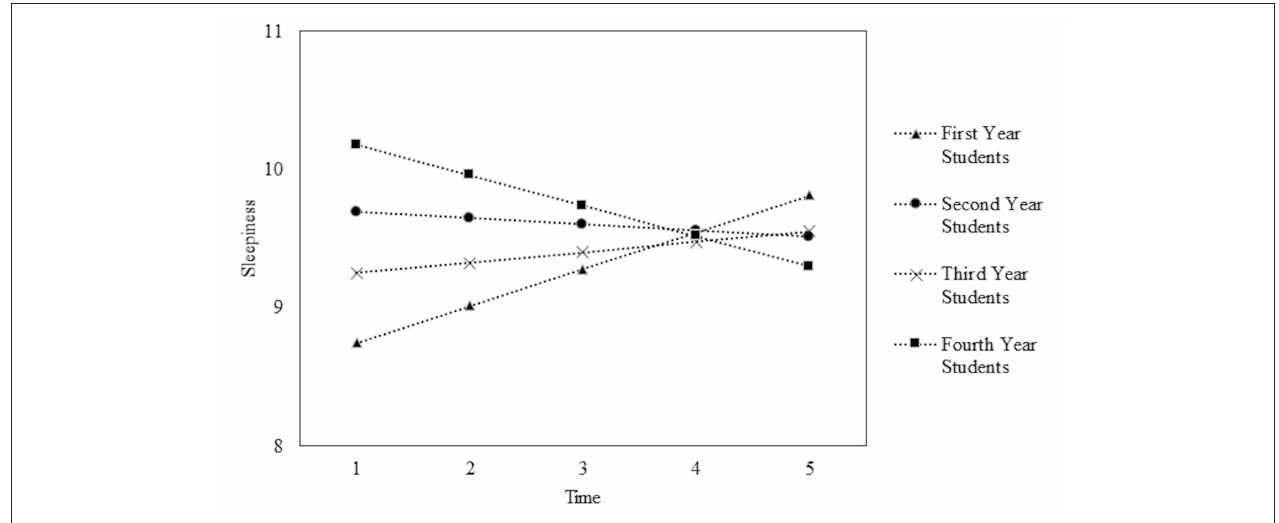
FIGURE 2 | Plot of average time courses for first, second, third, and fourth year veterinary students sleepiness scores across the academic year. Time 1 = beginning of the academic year and Time 5 = end of the academic